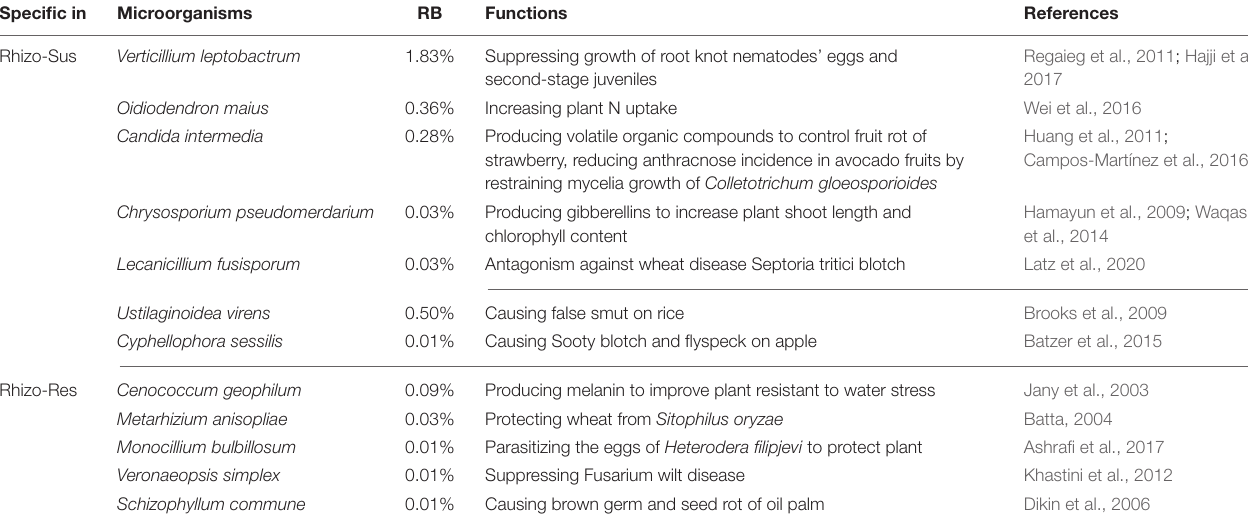
TABLE 2 | Main known functions of fungi specific for rhizosphere of C. oleifera (Rhizo-Sus) and C. yuhsienensis